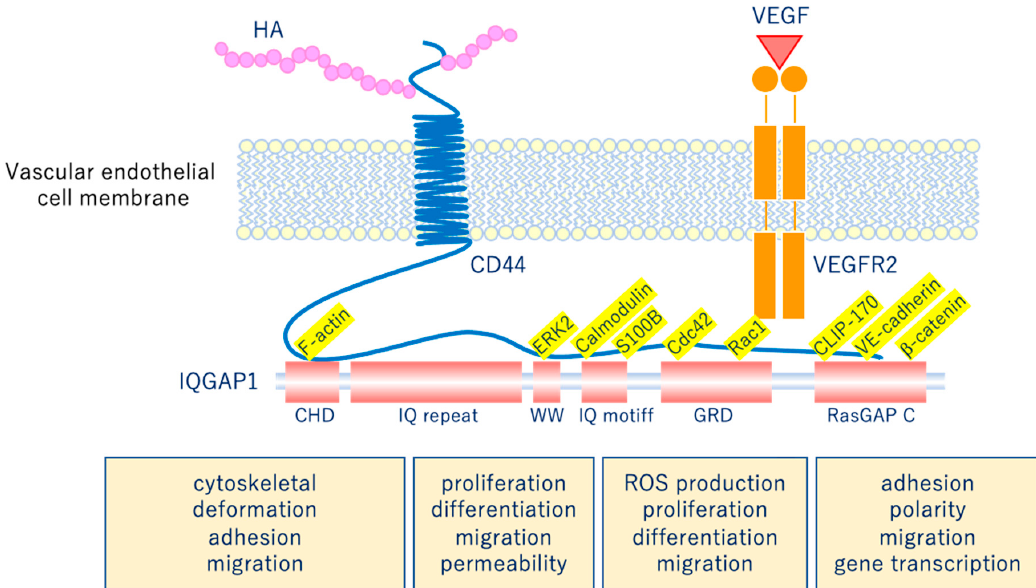
Figure 5. Vascular endothelial glycocalyx regulates cellular functions. Hyaluronic acid (HA) activates the HA/CD44 system by binding to CD44 and regulates various intracellular signaling through the multifunctional platform IQGAP1, as well as the vascular endothelial growth factor VEGF/VEGFR2 system. VEGF, vascular endothelial growth factor; VEGFR2, VEGF receptor 2; CD44, cluster of differentiation 44; CHD, calponin homology domain; IQ repeat, IQGAP specific repeat; ERK, extracellular-signal-regulated kinase; WW, region containing two tryptophans; S100B, S100 calcium-binding protein B; IQ motif, calmodulin-binding motif; Cdc42, cell division cycle 42; Rac1, Rac family small GTPase 1; GRD, Ras GTPase-activating protein-related domain; CLIP-170, cytoplasmic linker protein 170; RasGAP C, Ras GTPase-activating protein C terminus; ROS, reactive oxygen species.